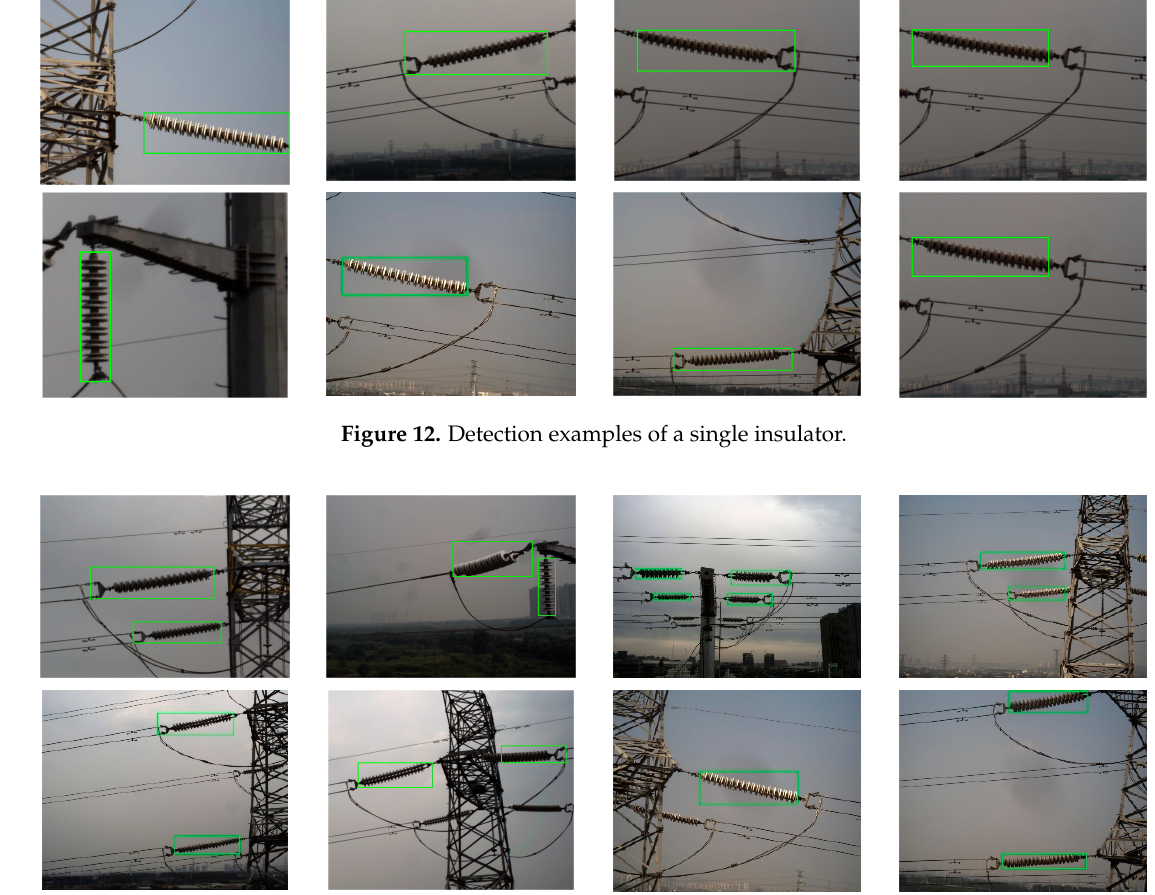
Figure 13. Detection example s of multiple insulators. Table 3. Comparison of time consumption and detection rate with other